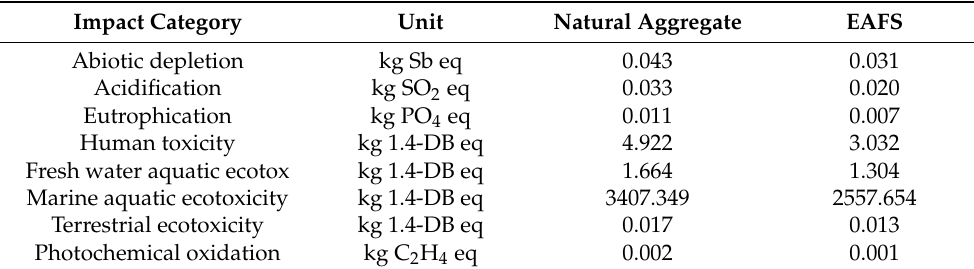
Table 6. Impacts associated with the processing of natural siliceous aggregates and electric arc furnace slags for use in bituminous